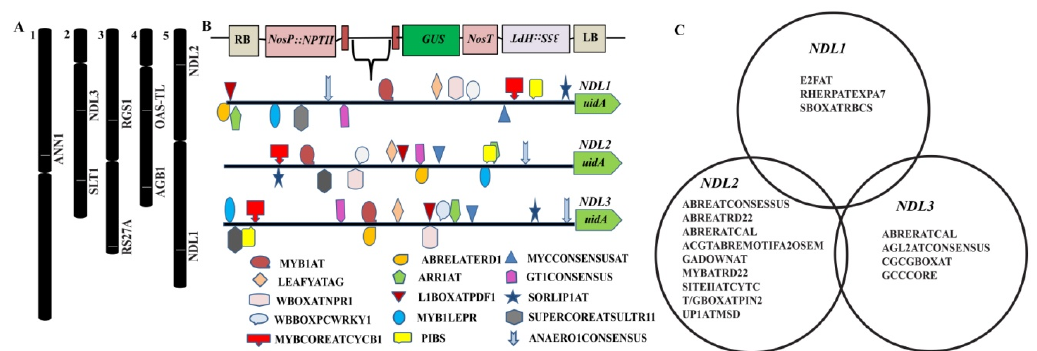
Figure 1. Mapping of the Arabidopsis N-MYC Downregulated Like Proteins ( AtNDL) gene family and